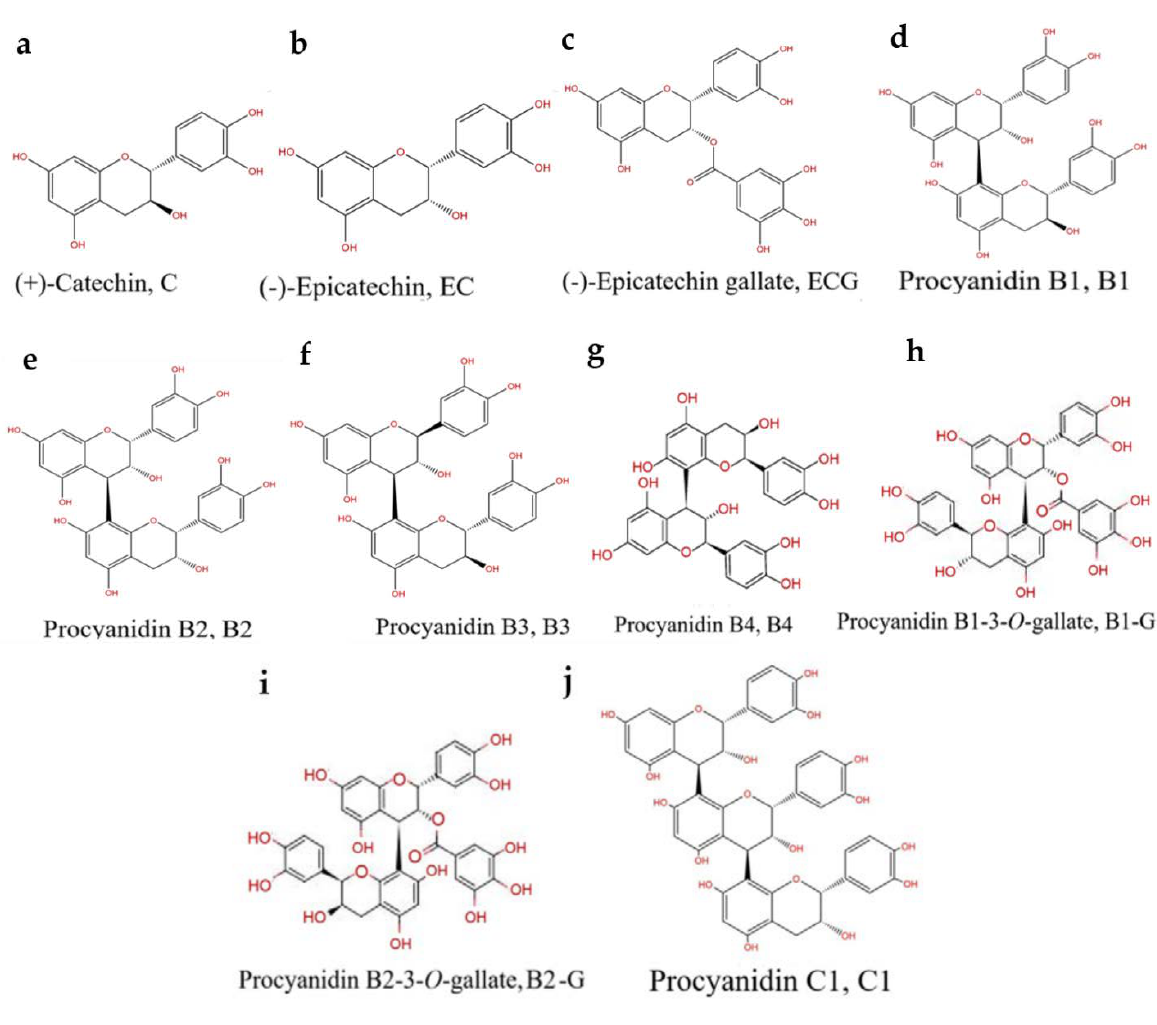
function [17]. NAD(P)H: quinone oxidoreductase 1 (NQO1), and heme oxygenase-1